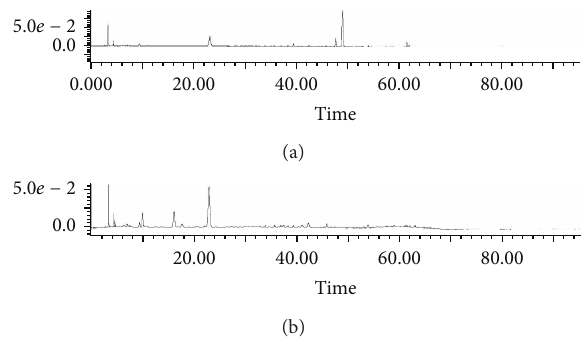
Figure 1: The global chromatograms of (a) raw Tianma extract and (b) MWT Tianma extract.